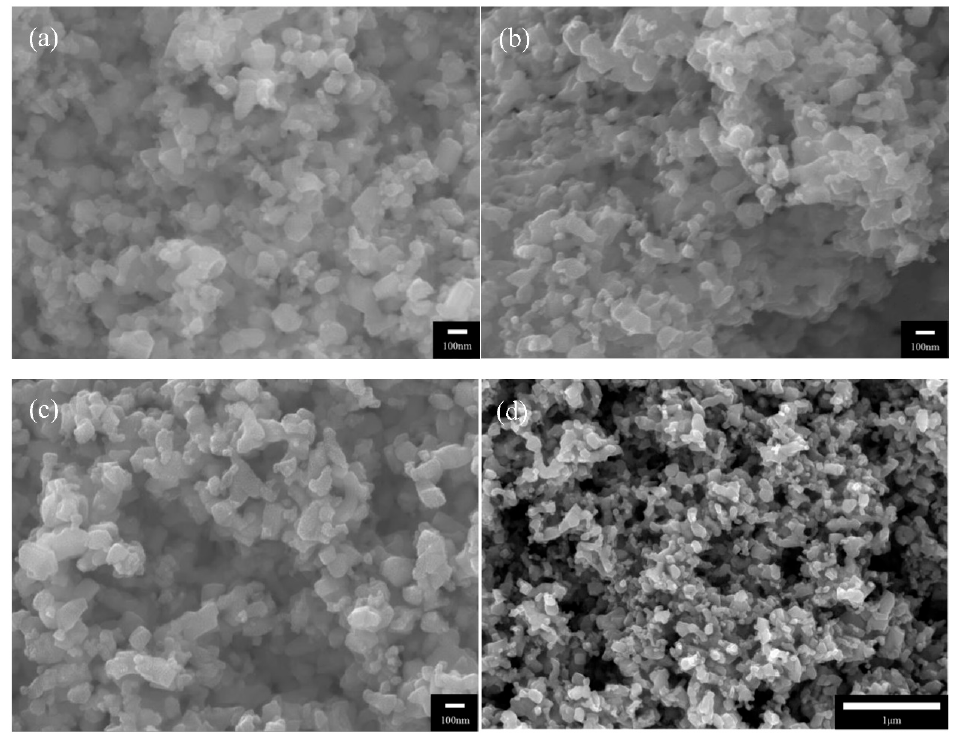
Figure 1. Scanning electron microscopy (SEM) images of the nitrided TiO 2 powders and the surface of the coating: ( a ) TiO 2 powder nitrided at 800 °C; ( b ) TiO 2 powder nitrided at 900 °C; ( c ) TiO 2 powder nitrided at 1000 °C; ( d ) surface morphology of the TiN coating.